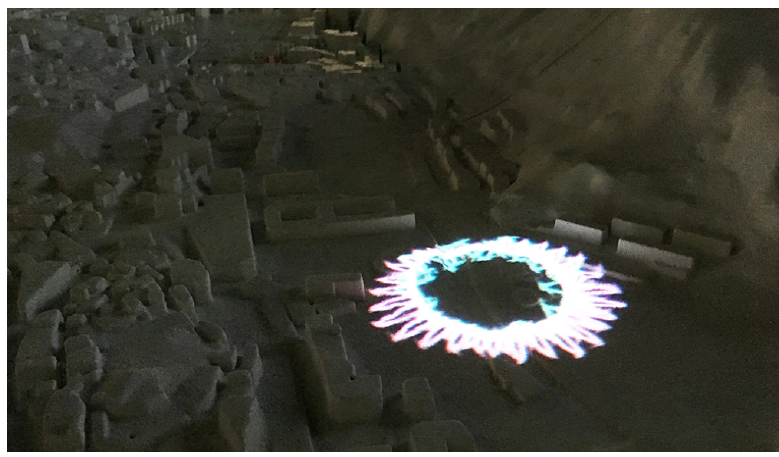
Figure 6. Sound circles on the 3D